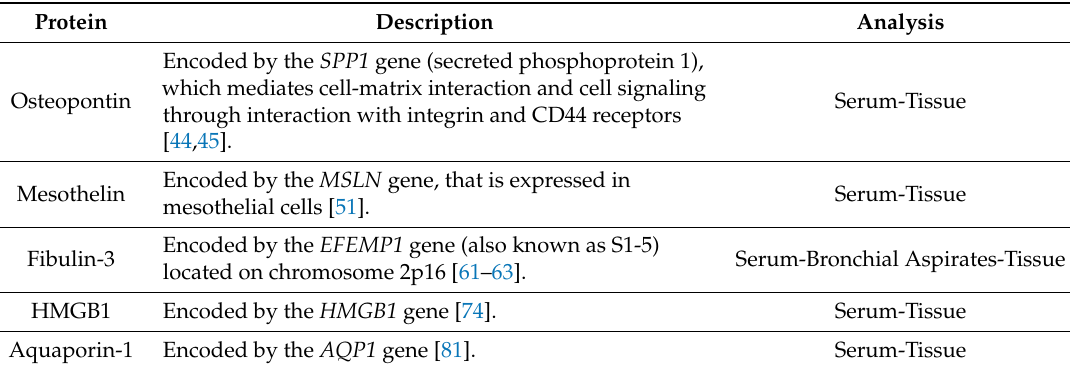
Table 1. Protein biomarkers for early diagnosis and prognosis of Malignant pleural mesothelioma (MM).